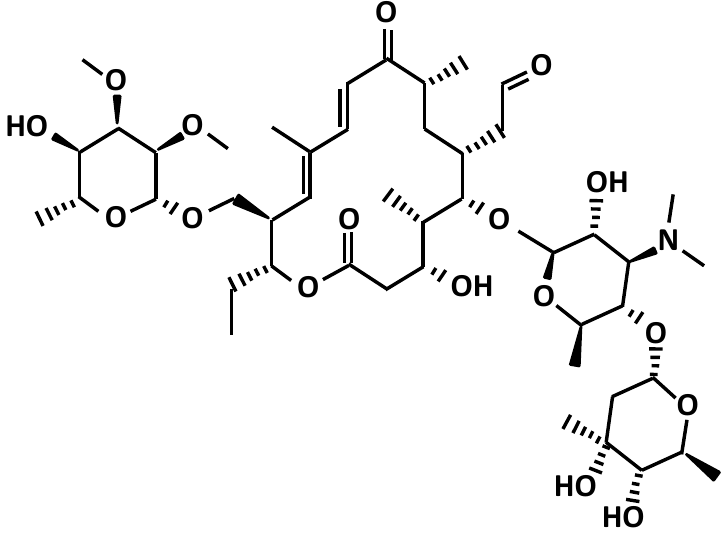
Figure 1. Chemical structure of Tylosin.